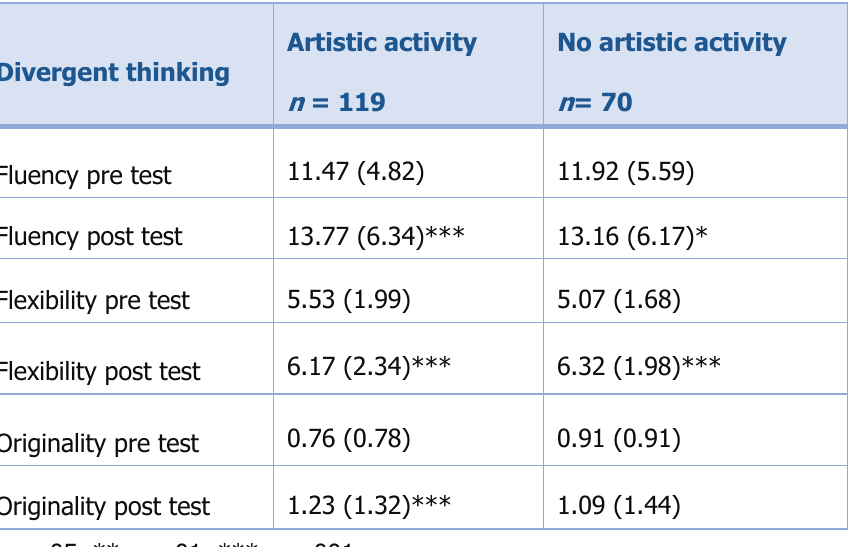
Table 4. Pre- and Post-Camp Differences in Divergent Thinking by Creative Activity